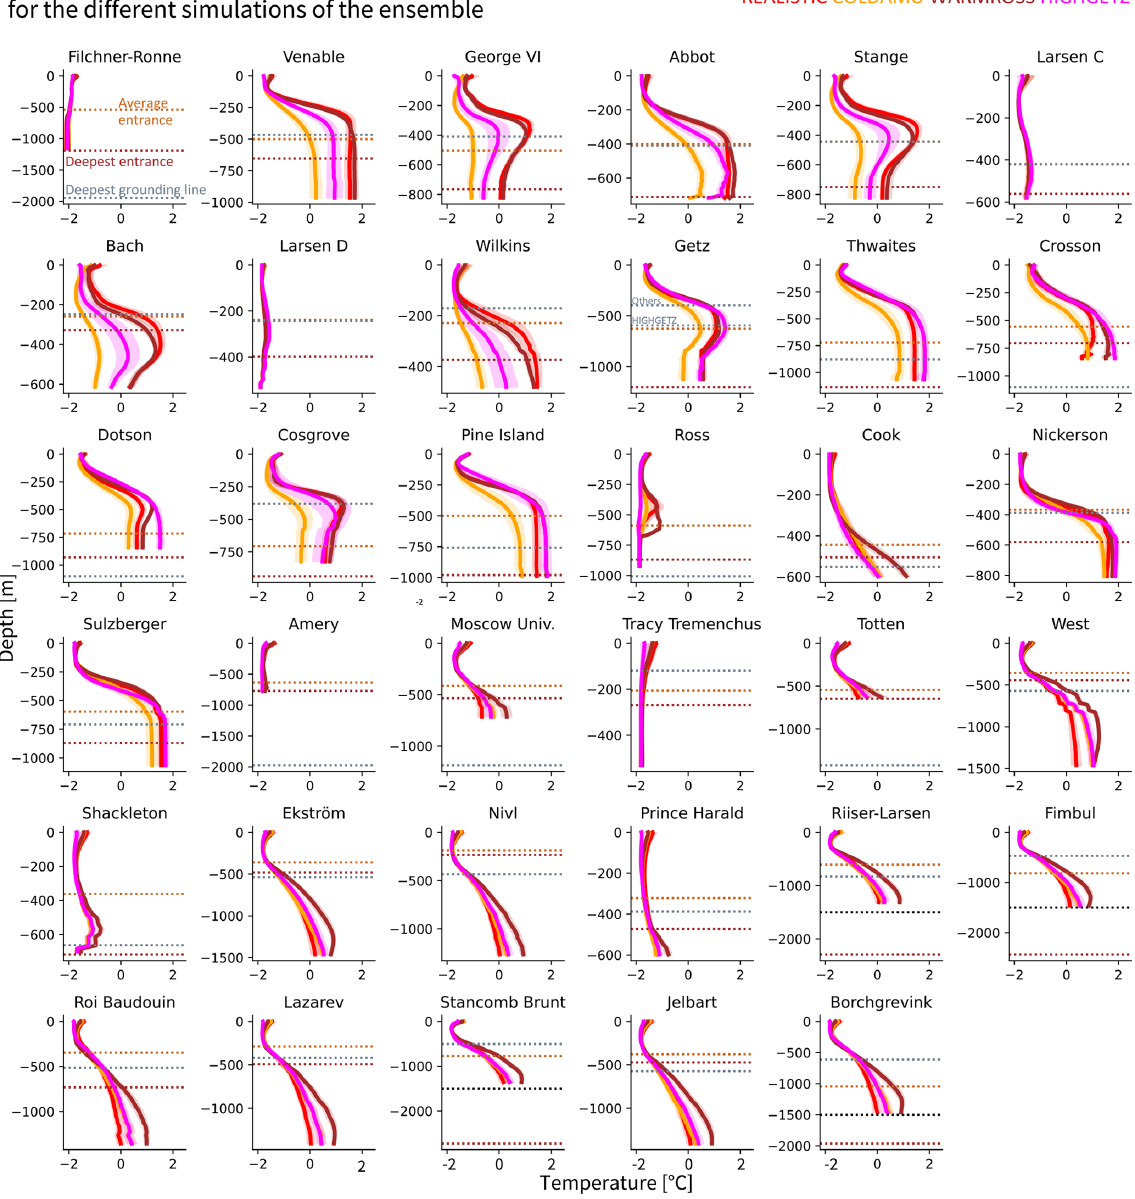
Figure 2. Comparison of mean input temperature profiles between the four different simulations (REALISTIC, COLDAMU, WARMROSS, HIGHGETZ), averaged over 50km on the continental shelf in front of the ice shelf. The shading represents the interannual variability (1 standard deviation over time). The horizontal dotted lines show the average depth of the bed at the ice front (light brown), the largest depth of the bed at the ice front (dark brown), and the largest depth of the grounding line (grey). The deepest grounding line point for Getz Ice Shelf is different in the HIGHGETZ compared to the other simulations due to the artificial thinning in the latter (see Sect. 2.1.2). For a few ice shelves, the deepest entrance is deeper than 1500m depth, but the profiles are defined over the continental shelf (depth shallower than − 1500m). A black dotted line denotes the 1500m limit in this case. For Stange and Larsen C ice shelves, the average entrance depth and the deepest grounding line